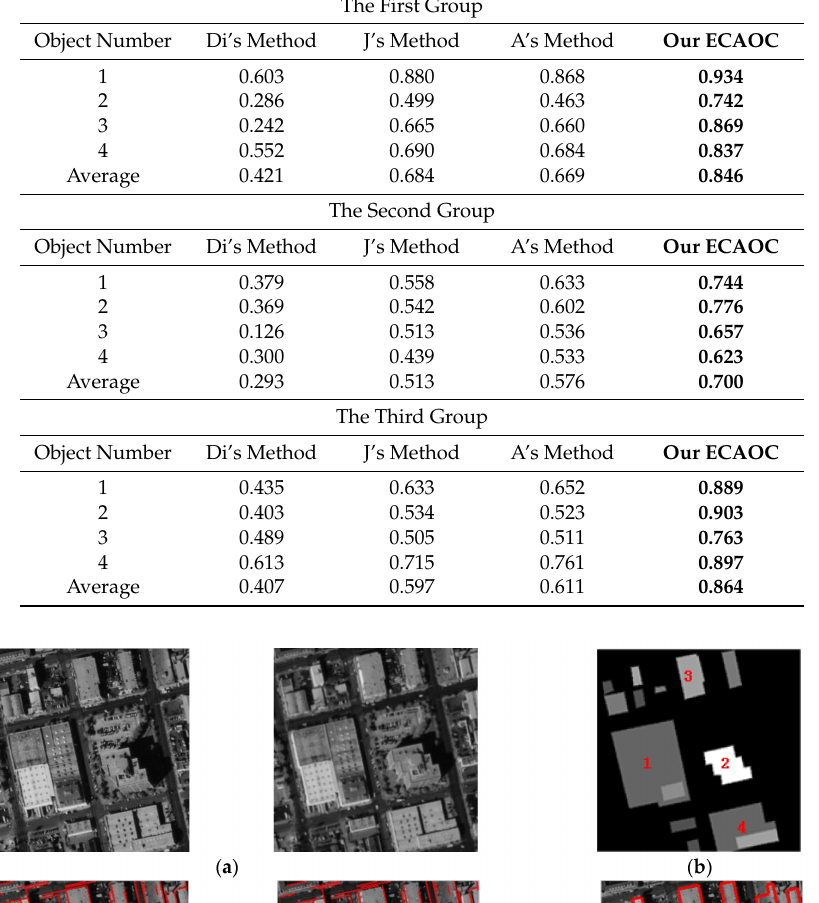
Table 2. The object accuracy quantitative contrast experiment results of disparity map.